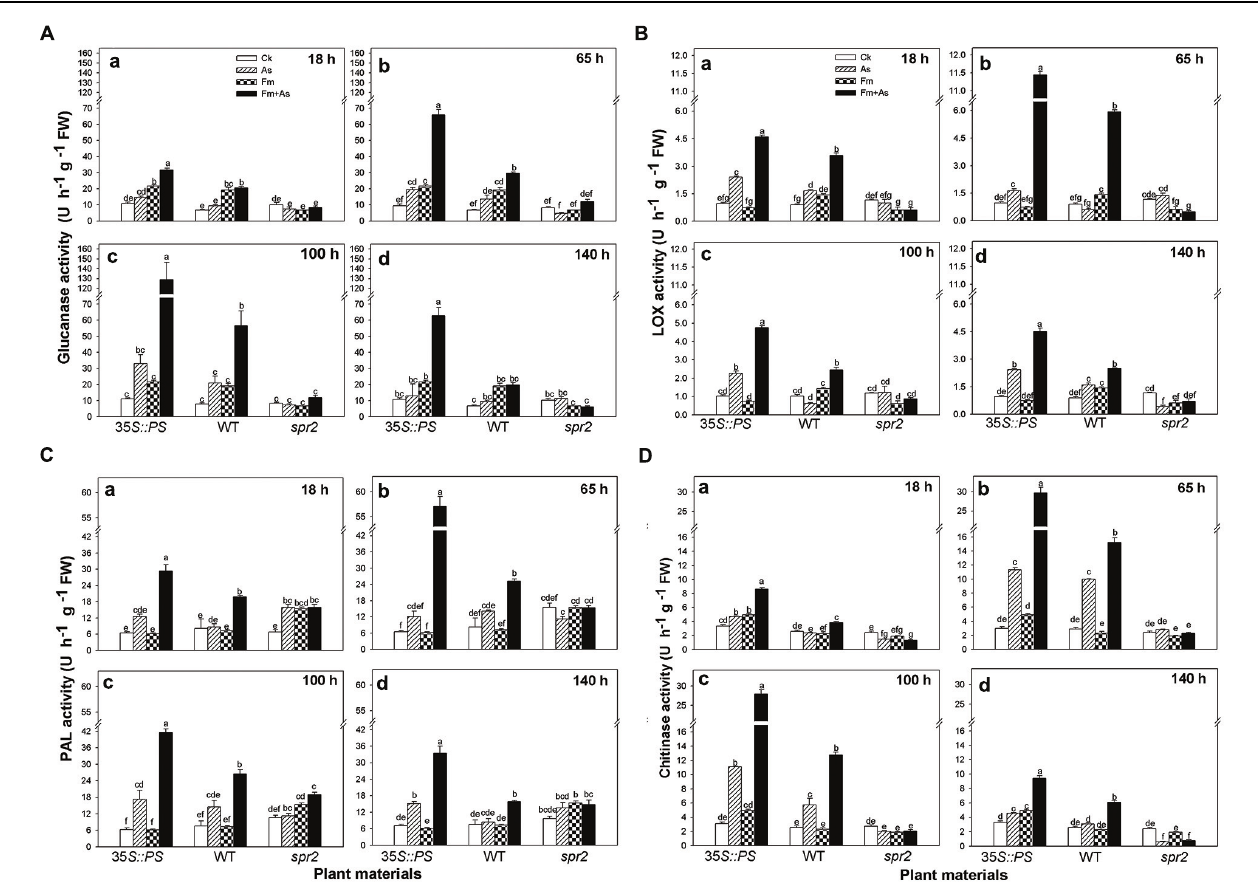
FIGURE 4 | Levels of defense-related enzymes in leaves of tomatoes with mycorrhizal colonization and pathogen infection. Wild-type (WT) and mutant plants ( 35S::PS and spr2 ) of tomato were pre-inoculated with mycorrhizal fungus Funneliformis mosseae and later inoculated with A. solani , the causal agent of early blight disease of tomato. Four defense-related enzymes are β -1,3-glucanase (A) , LOX (B) , PAL (C) , and chitinase (D) . Enzymatic activities were analyzed 18 (a), 65 (b), 100 (c) and 140 h (d) after pathogen inoculation. Four treatments included: (1) CK: control plants without pathogen and mycorrhizal inoculation; (2) As: plants inoculated with A . solani only; (3) Fm: plants inoculated with F. mosseae only; (4) Fm + As: plants inoculated with both F. mosseae and A . solani . Three tomato genotypes included: (1) WT: wild type plant; (2) 35S::PS : Prosystemin-overexpressing 35S::PS plant; (3) spr2 : JA biosynthesis mutant plant. Values are means ± SE from three sets of independent experiments with three pots per treatment for each set of experiments. Significant differences among treatments were tested at P = 0.05 by Tukey post hoc